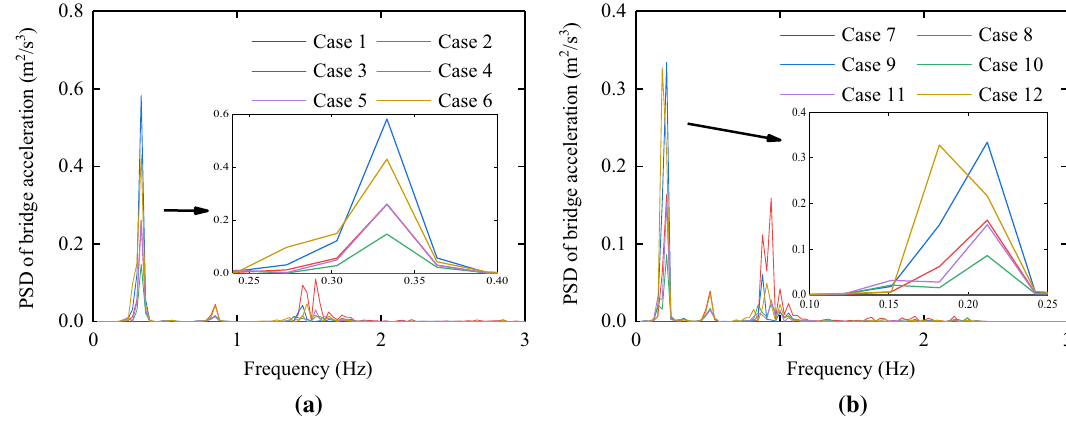
Fig. 17 PSD of the lateral bridge acceleration: a cases 1–6; b cases